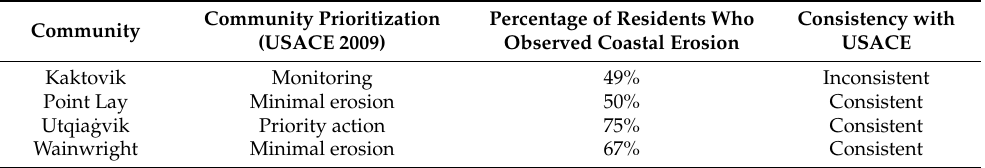
Table 6. Measured rates of erosion (community prioritization was adapted from